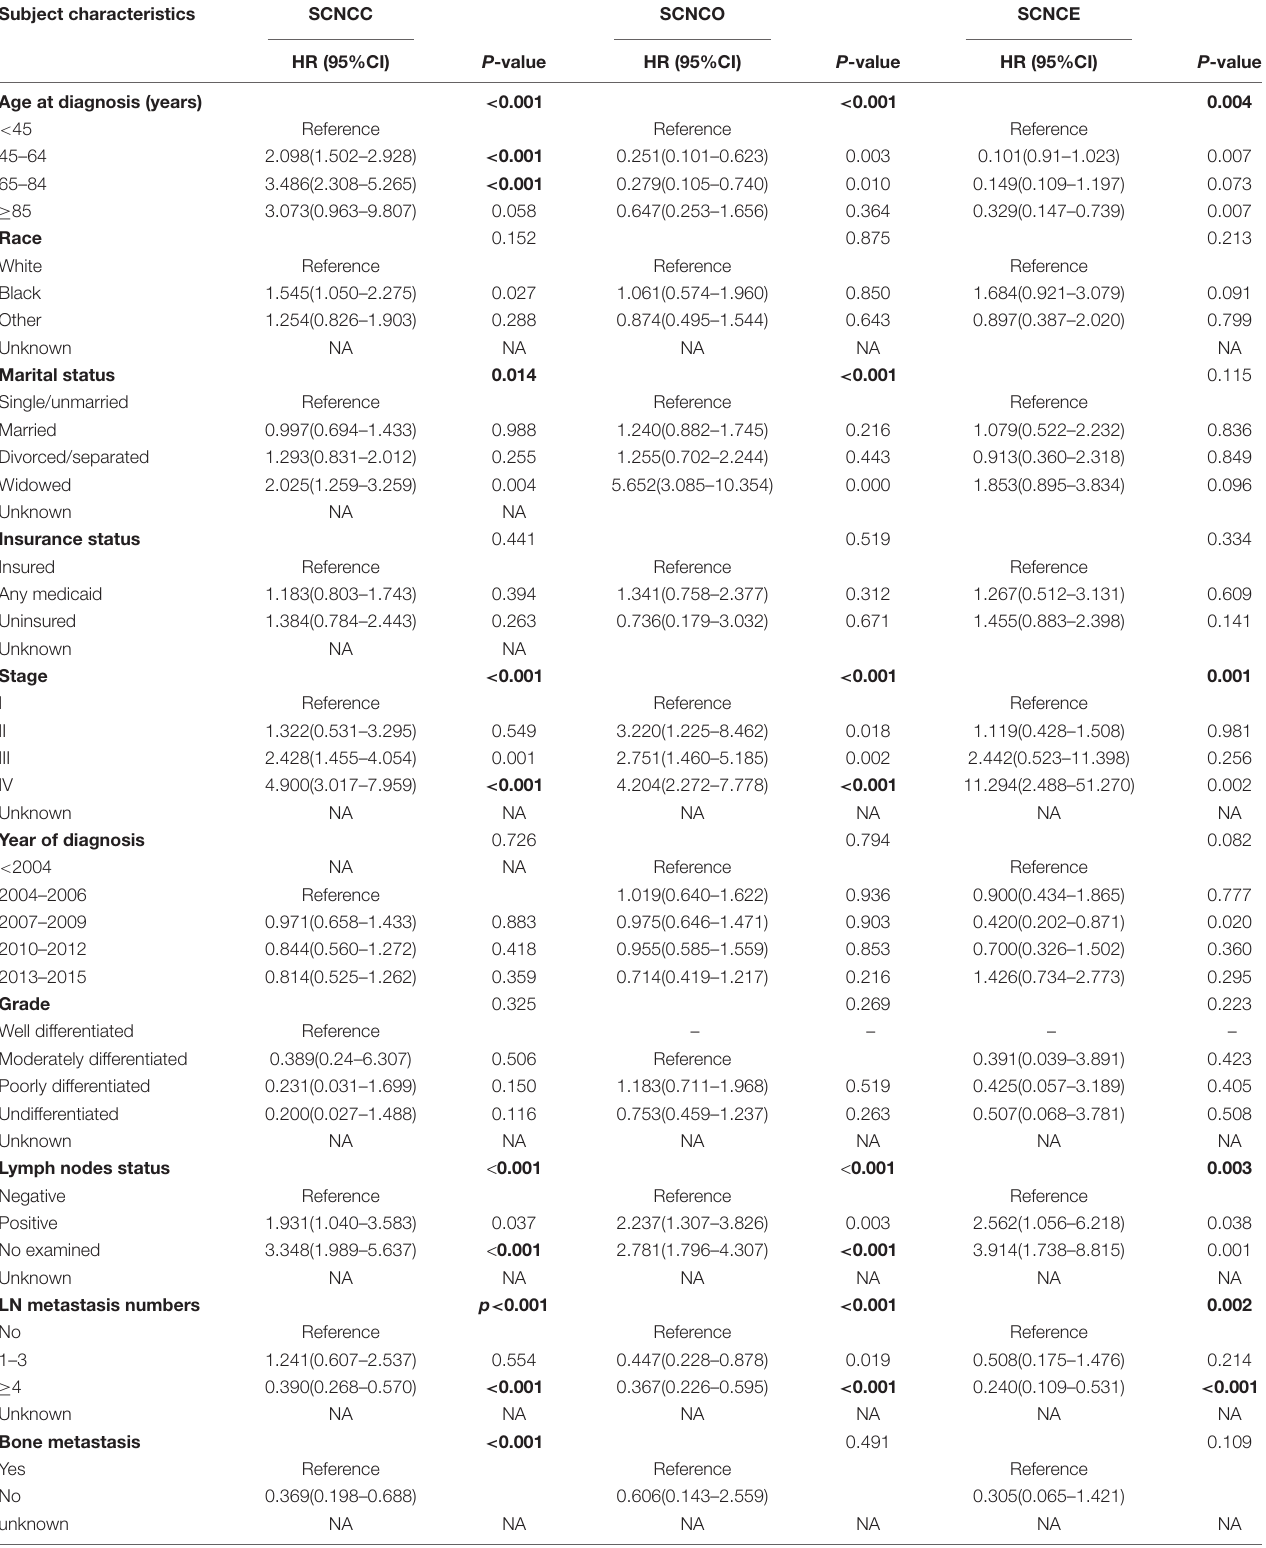
TABLE 2 | Univariable Cox regression for analyzing the associated factors for developing small-cell neuroendocrine carcinoma of the gynecologic tract